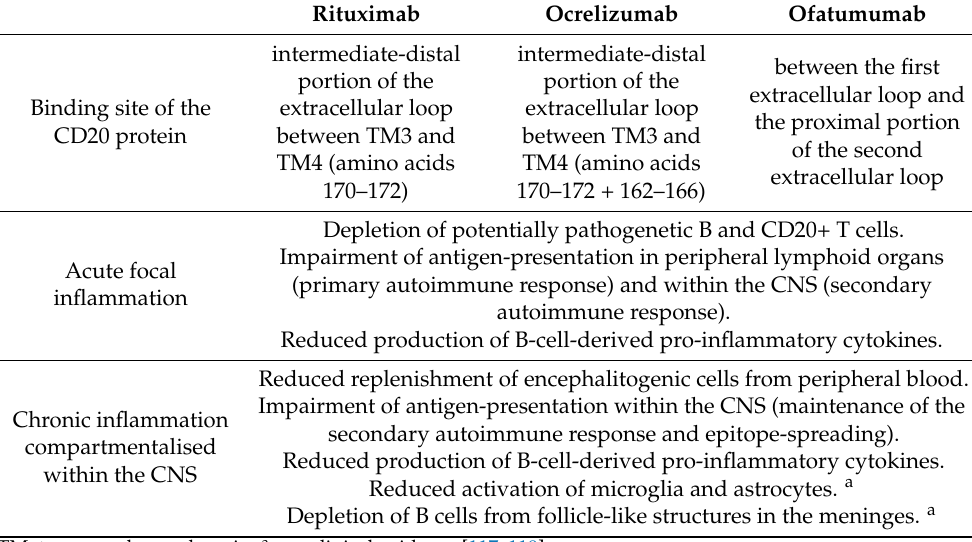
Table 1. Binding site of B-cell-depleting antibodies used for the treatment of MS and supposed mechanisms mediating their impact on acute and chronic